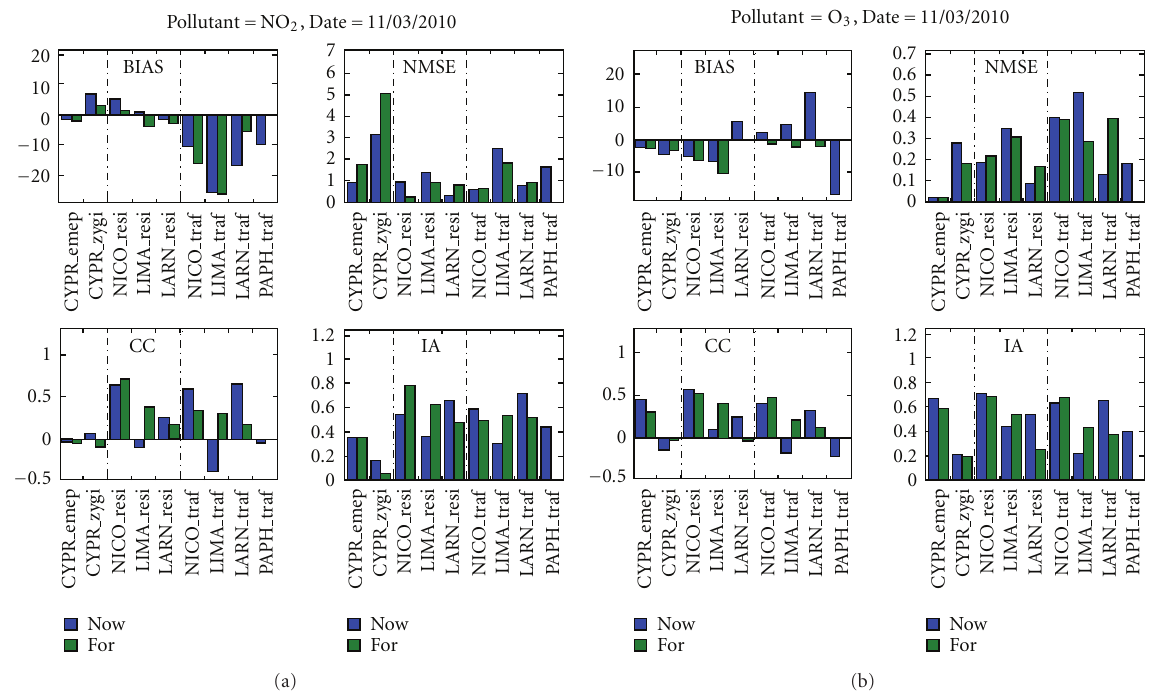
Figure 8: Statistical indices calculated for the 11th of March 2010 as regards NO 2 (a) and O 3